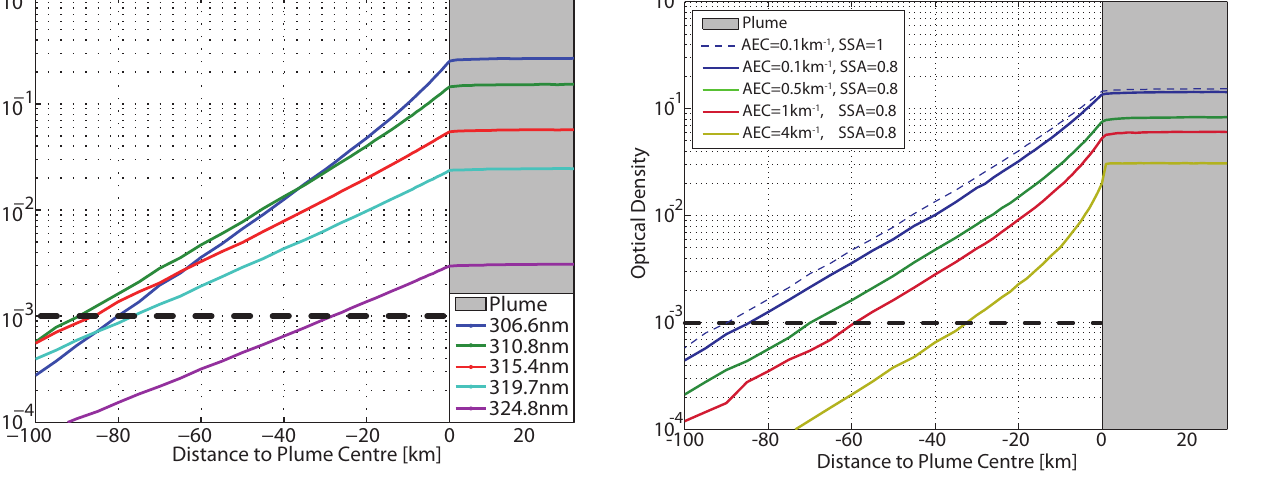
Fig. 15. Optical densities for model scenario B2: Depicted are Simulated Optical densities at 310.8nm as a function of distance to an extended volcanic cloud (scenario B2) and varying ash content. Volcanic ash is simulated with a SSA=0.8 and varying AECs. For comparison, the dashed blue line shows the result for a cloud with a purely scattering aerosols at an AEC of 0.1km − 1 (see fig. 14). The dashed black line represents the assumed detection limit of 10 − 3 in optical density. Higher ash content reduces the detection limit, but a detection range of > 60 km is still obtained for AEC < 1 . Only for extremely thick plumes, such as those encountered incloseproximitytothevolcanicsource, doesthedetection range dropfurther.